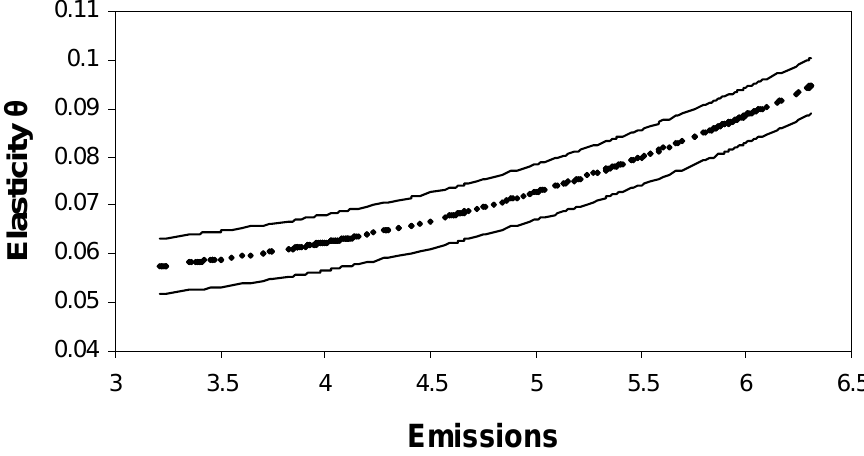
Figure 1. Output elasticity of Figure 1: Output Elasticity of Emissions